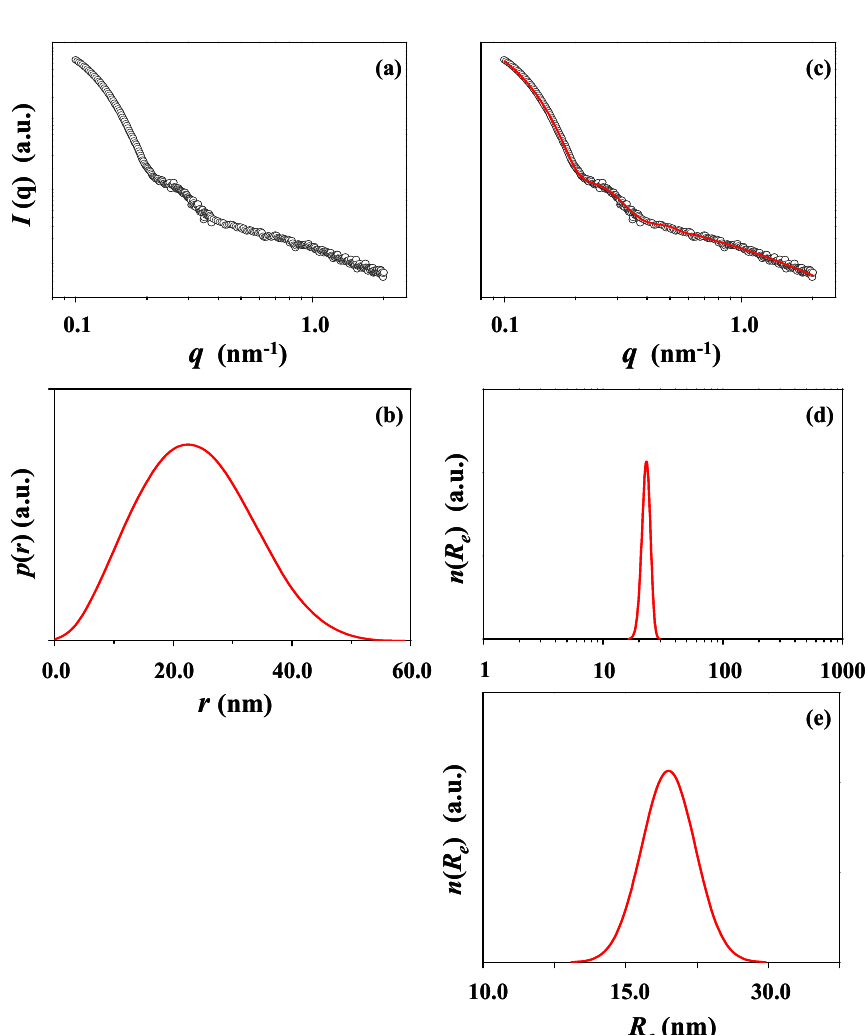
Figure 5. X-ray scattering data analysis of the l -PDGE- b -PTEGGE micelle formed in an ethanol/water (75/25 in wt/wt ) mixture: ( a ) scattering data measured at room temperature; ( b ) pair distance distribution functions p ( r ) obtained by the data analysis using the IFT method; ( c ) data analysis result, where the open dot symbols are the measured data and the red solid line was obtained by fitting the data using the three phase ellipsoid approach; ( d,e ) radius distribution obtained by the data analysis with the three-phase ellipsoid approach.